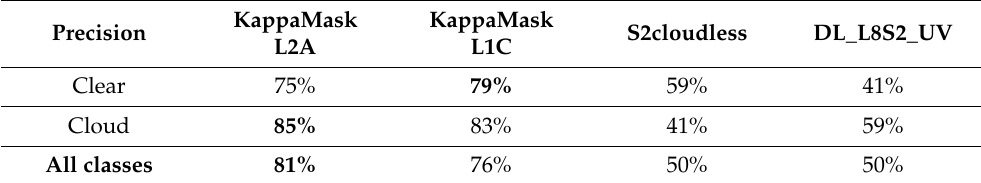
Table 7. Dice coefficient evaluation performed on the test dataset for KappaMask Level-2A, Kappa-